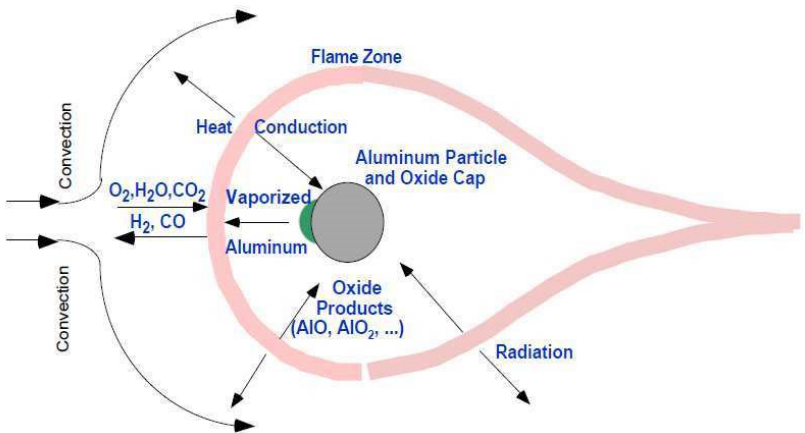
Figure 2. Combustion of an aluminum particle